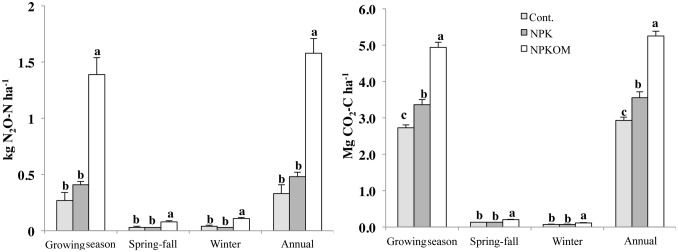
Six-year averages of cumulative seasonal N2O and CO2 emissions.The treatments were Control (Cont. no fertilizer applied), chemical fertilizer (NPK), and chemical fertilizer plus composted pig manure (NPCOM). Means shown are the average growing season, spring-fall (October and April), winter (November–March), and annual emissions in the corn-soybean-wheat rotation from May 2006–April 2012. Line bars represent standard errors. Bars designated with the same letters within each season are not significantly different (P>0.05). n = 3.